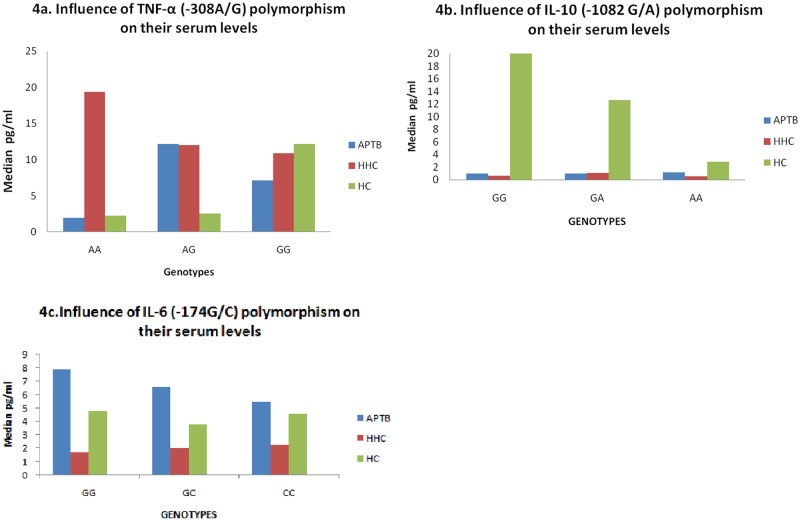
Comparision of cytokine gene polymorphisms of TNF-α (-308A/G), IL-10(-1082G/A) and IL-6(-174G/C) with serum levels.(4a, 4b, 4c) Vertical axis- serum levels showing median values; Horizontal axis- genotypes of TNF- α (-308A/G); IL-10(-1082G/A) and IL-6(-174G/C),APTB—active pulmonary tuberculosis patients; HHC-household contacts; HC-healthy controls.